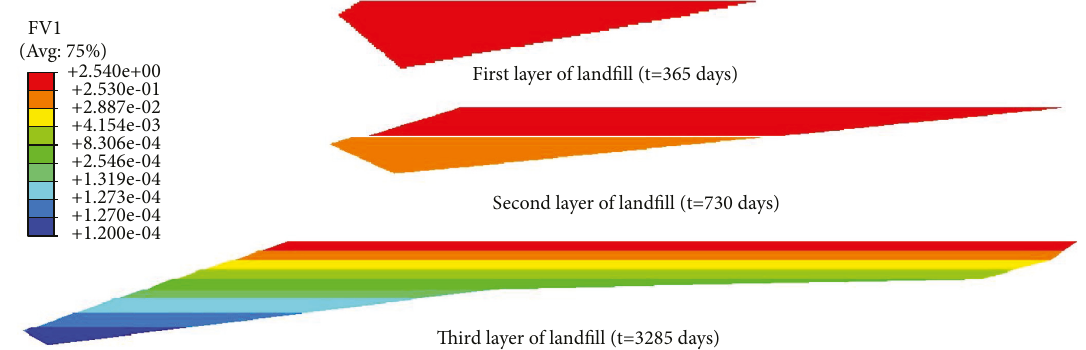
First layer of landfill (t=365 days)